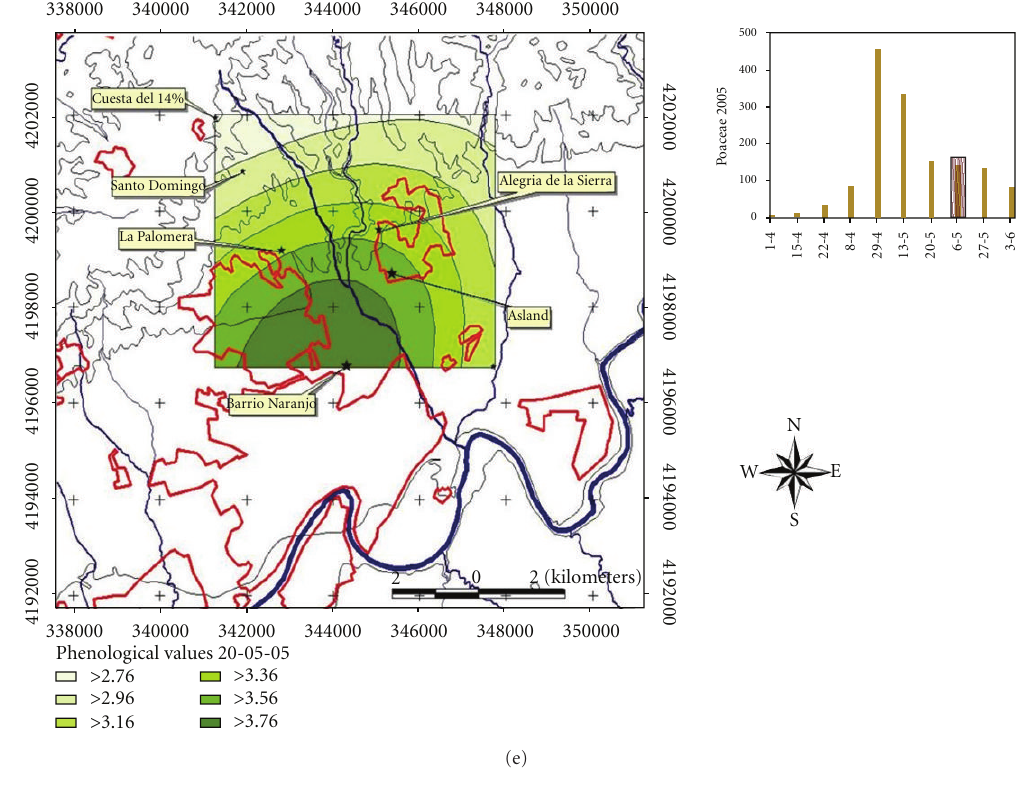
Figure 7: Phenological maps. Year 2005. Table 2: Results of Descriptive Analysis. Year